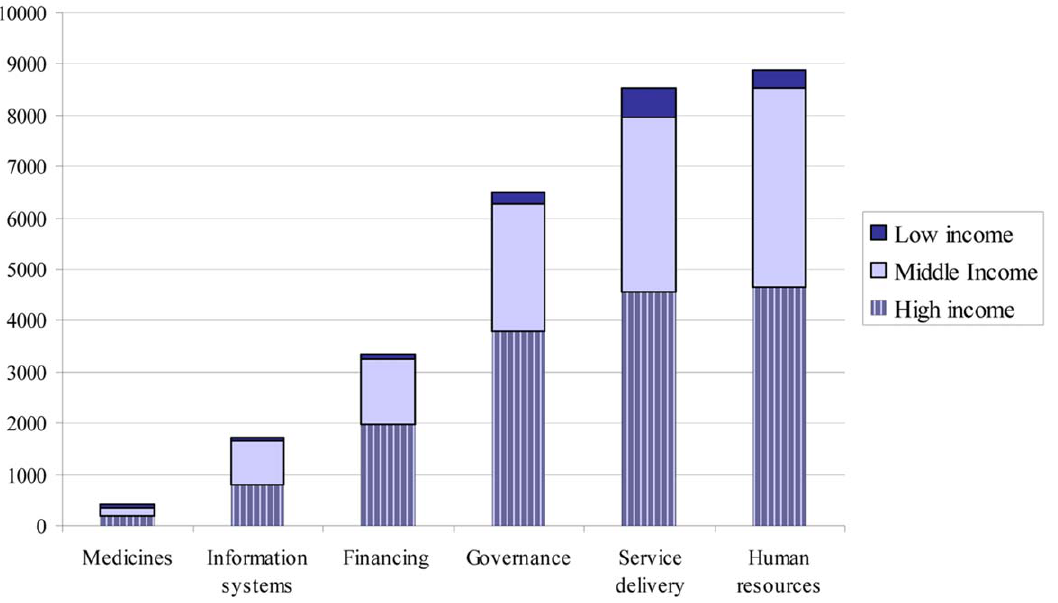
Figure 2. Number of HPSR publications relevant to LMICs by topic and residence of lead author, grouped by income group (2003– 2009).